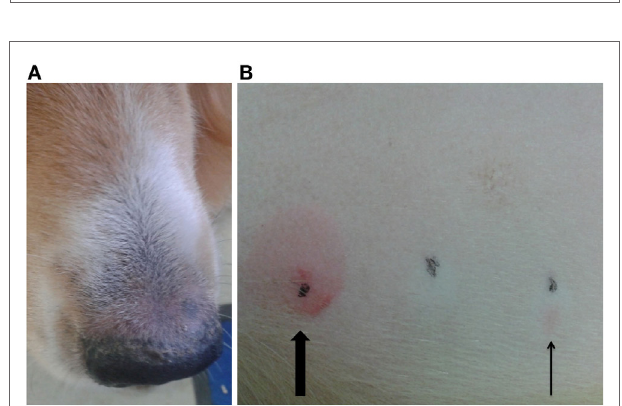
FigUre 3 | Dog P1 (mixed-breed, male, 8 years) developed a severe erosive perianal inflammation with purulent secretion after PB initiation (a) . Patch test revealed a positive reaction to the 10% phenobarbital (arrowed) (B) .